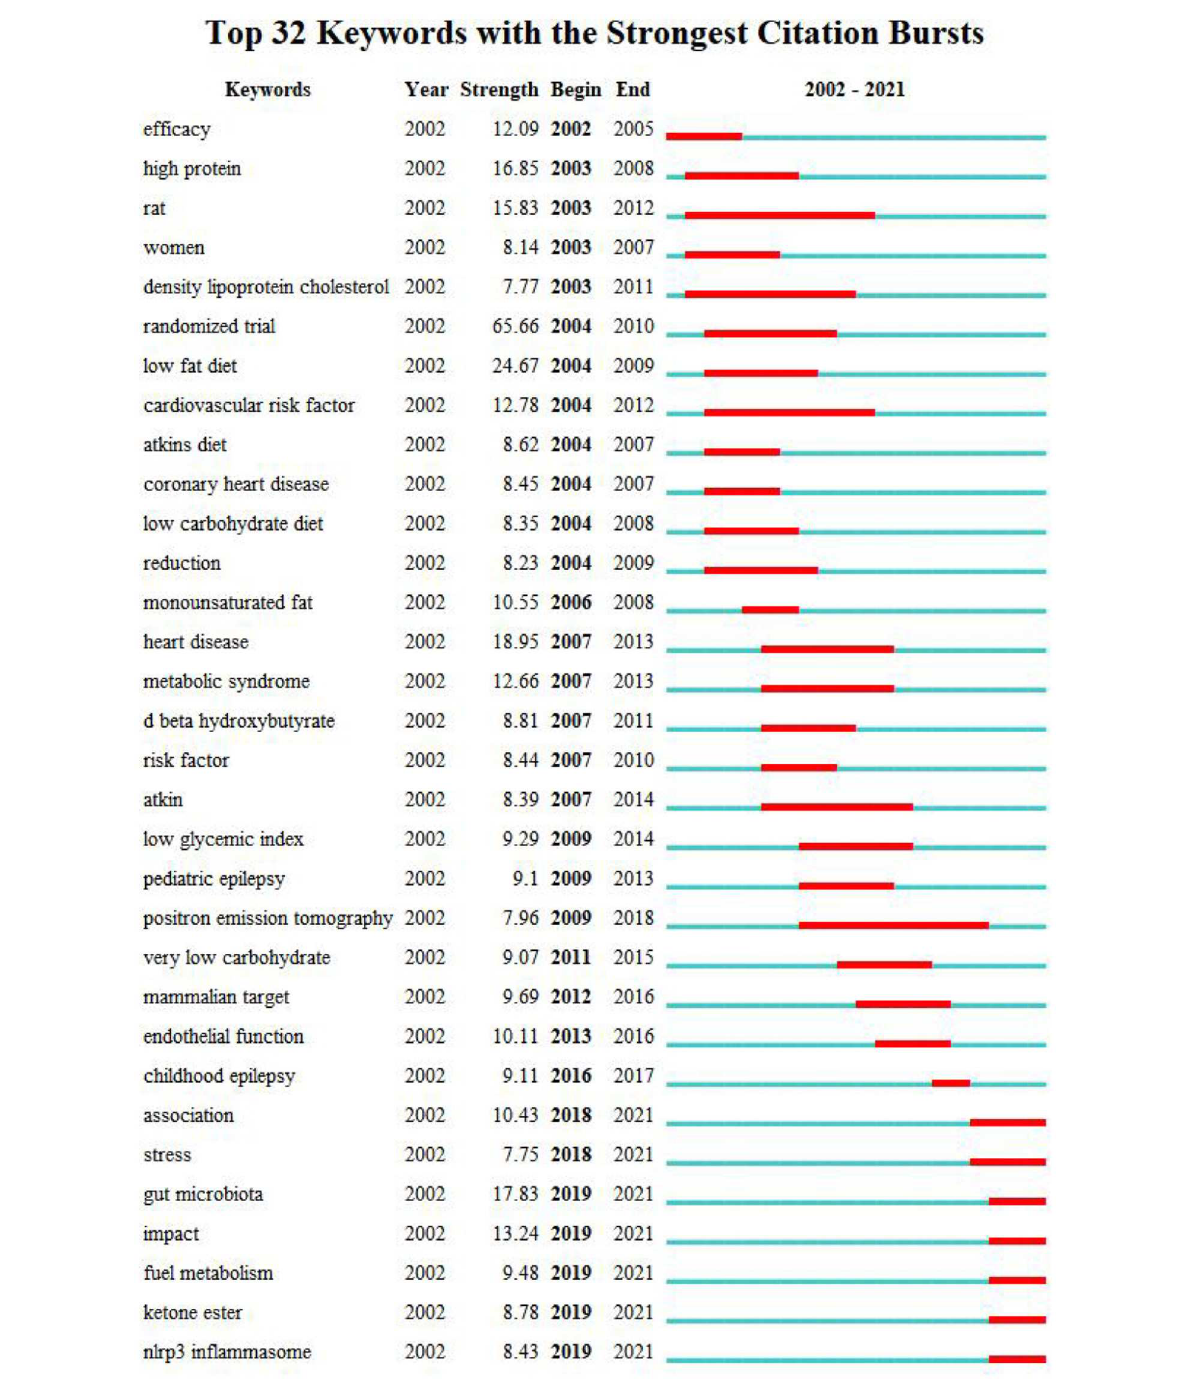
FIGURE9 Map of keyword with the strongest citation bursts on LChD from 2002 to